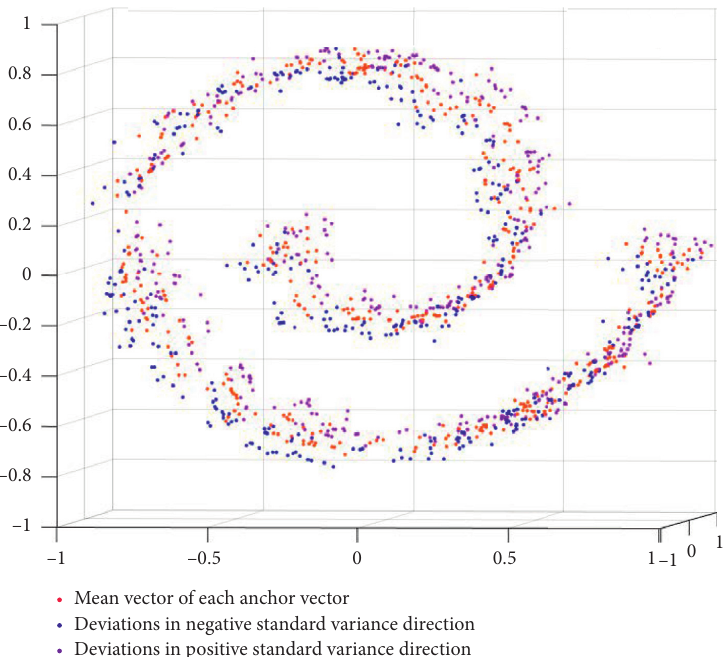
Figure 6: The mean vectors and deviations because of distribution parameters at each anchor vector locality